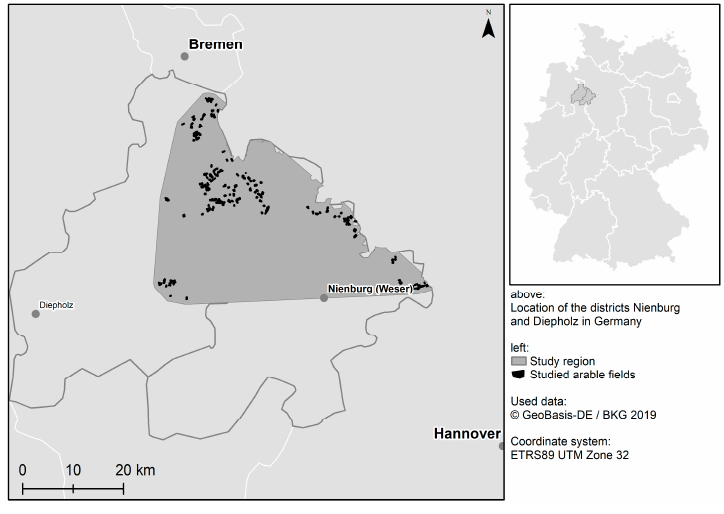
Figure 1. Map of the study region with the districts of Nienburg and Diepholz in Lower Saxony, northwest Germany. The location of the studied fields is indicated by black dots.